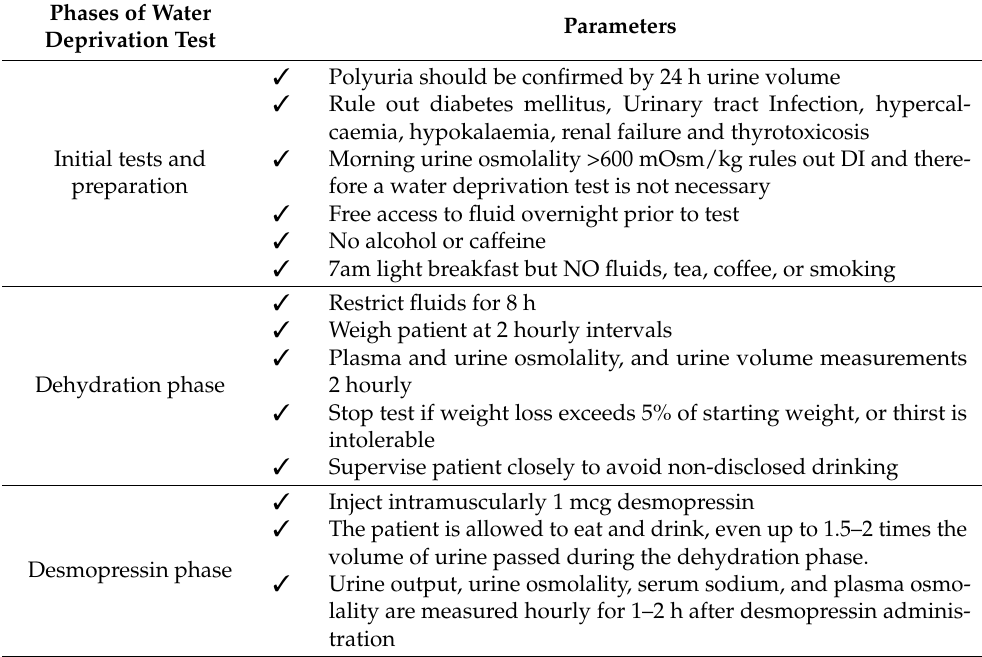
Table 2. Protocol for water deprivation/desmopressin